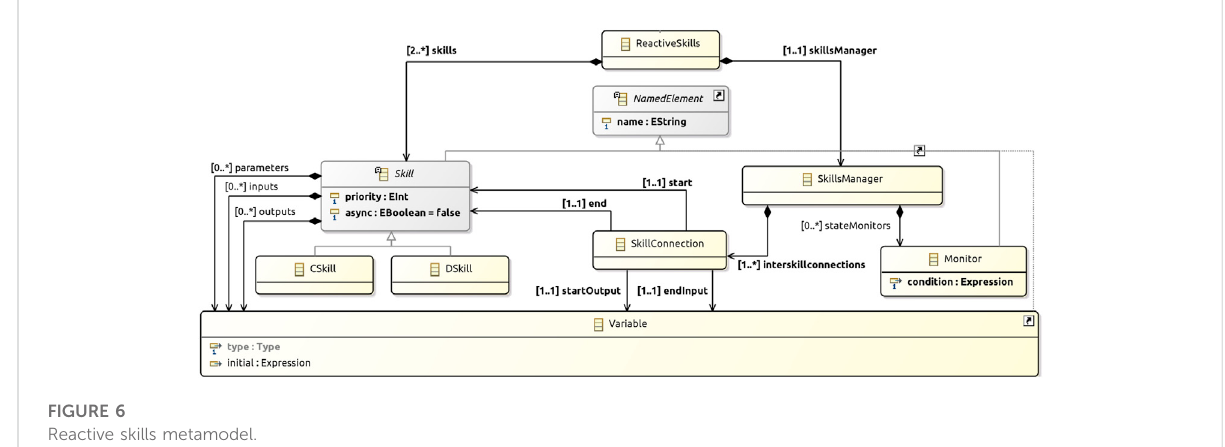
FIGURE 6 Reactive skills metamodel.